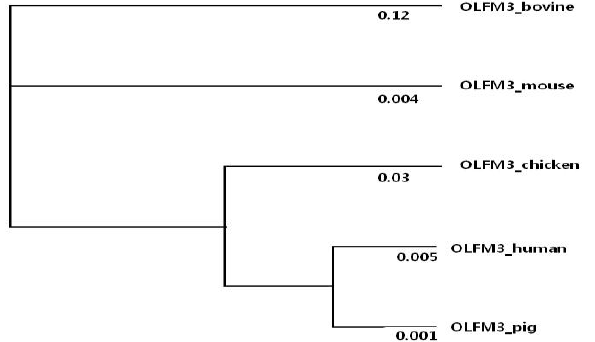
Figure 2. Phylogeny of OLFM3. Branch lengths were estimated by maximum likelihood under the free-ratio model that assumes an independent  -value for each branch.  -values are shown for each